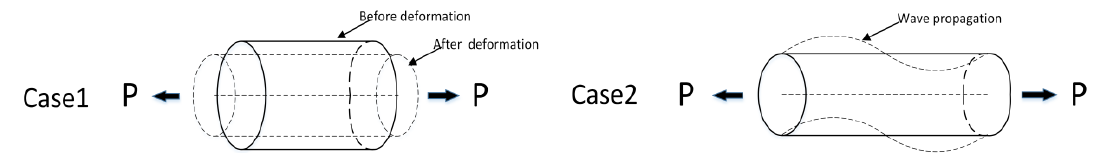
Figure 14. The equilibrium state of the virtual work.